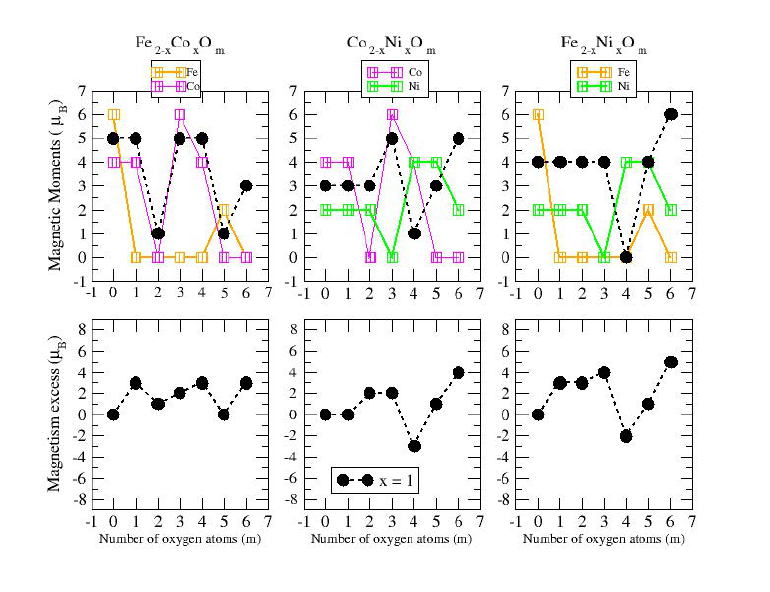
Figure 12. ( upper pannels ) Total magnetic moments of A 2 − x B x O m clusters (A, B = Fe, Co, Ni; x ≤ 2; m = 1–6). Brown, pink and green curves correspond, respectively, to Fe n O m , Co n O m and Ni n O m oxides. Black curves correspond to nanoalloys with x = 1. ( lower panels ) Magnetism excess of ABO m nanoalloys (A, B = Fe, Co, Ni; m = 1–6).